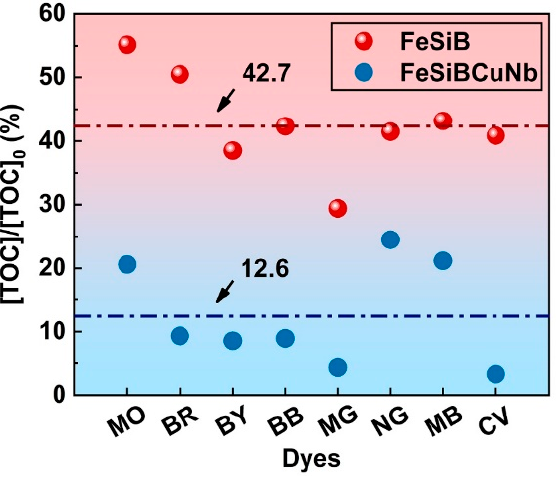
Figure 11. TOC removal rate ([TOC]/[TOC] 0 ) of eight dyes using Fe 78 Si 9 B 13 (FeSiB) and Fe 73.5 Si 13.5 B 9 Cu 1 Nb 3 (FeSiBCuNb) after 15